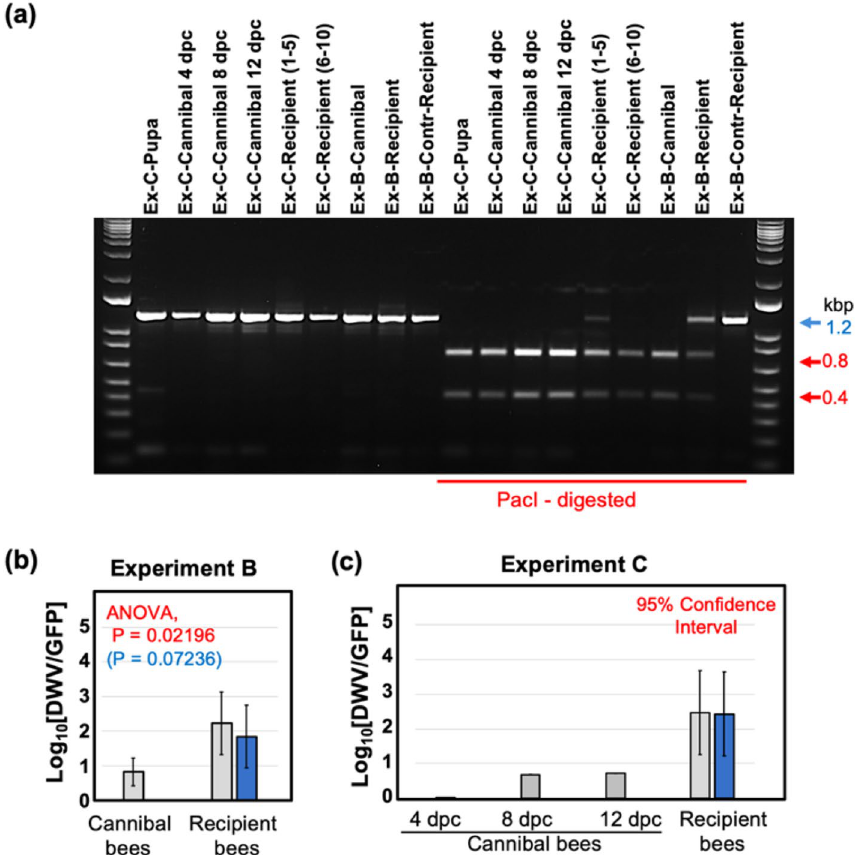
Figure 4. Dynamics of DWV-GFP in worker bees following cannibalism and trophallactic transmission. ( a ) Identification of DWV-GFP-derived viral progeny in the treatment group pools of Experiments B and C. The analysis included amplification of a 1237 nt RT-PCR fragments corresponding to the 5 ′ -terminal region of DWV genome, digestion with Pac I, and separation of the digestion reaction products by agarose gel electrophoresis. The untreated 1237 nt fragments (left) and Pac I-digested (right). The digestion fragments (left) derived from DWV-GFP, expected fragment sizes, undigested (blue arrow) and digested (red arrows), are shown on the right. Treatment groups are shown above, prefixes “Ex-B-” and “Ex-C-” indicate samples of the Experiment B and C treatment groups, respectively. Two pools of 5 Recipient cages were analyzed for Experiment C. ( b , c ) Accumulation of GFP deletion variants derived from the DWV-GFP genome in the recipient bees which received the virus by trophallaxis from “Cannibal” bees. Columns indicate ratios between DWV RNA load and GFP RNA load in a sample, grey columns—for overall DWV levels, blue columns—for DWV originated from DWV-GFP (when wild-type DWV without Pac I site was present). Error bars indicate ( b ) standard deviation or ( c ) 95% Confidence Interval, for ( b ) ANOVA P-values for uncorrected DWV load (red) and corrected DWV load (blue) are